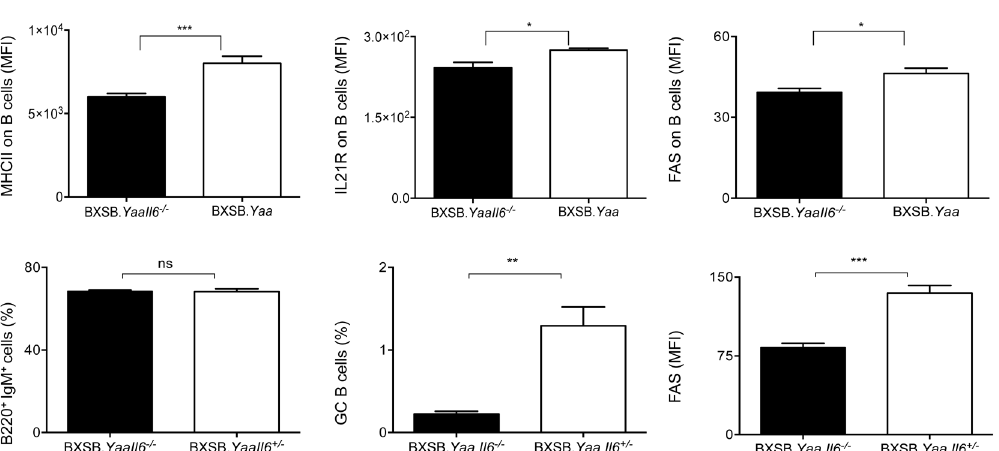
Fig 5. Early activation of B cells in BXSB. Yaa mice is reduced in the absence of IL6. 6 – 7.5 weeks old BXSB. Yaa (n = 5) and BXSB. Yaa . Il6 -/- (n = 8) mice were bled and (A) cells were stained with fluorescent-labeled antibodies to B220, IgM, MHCII, IL21R and FAS and analyzed by FACS. Expression of MHCII, IL21R and FAS on viable single cells gated on B220 + IgM + is determined as MFI. (B) The frequencies of splenic total B cells (B220 + IgM + ) and GC B cells (B220 + IgM + PNA hi FAS + GL7 + ) were determined and expressed as percentages of total cells. Expression levels of FAS on GC B cells are depicted as mean fluorescence intensity (MFI). Data are expressed as mean ± SEM of individual values obtained from each mouse and statistical analysis is done using two tailed unpaired t test. * p < 0.05, ** p < 0.01, *** p < 0.0001.